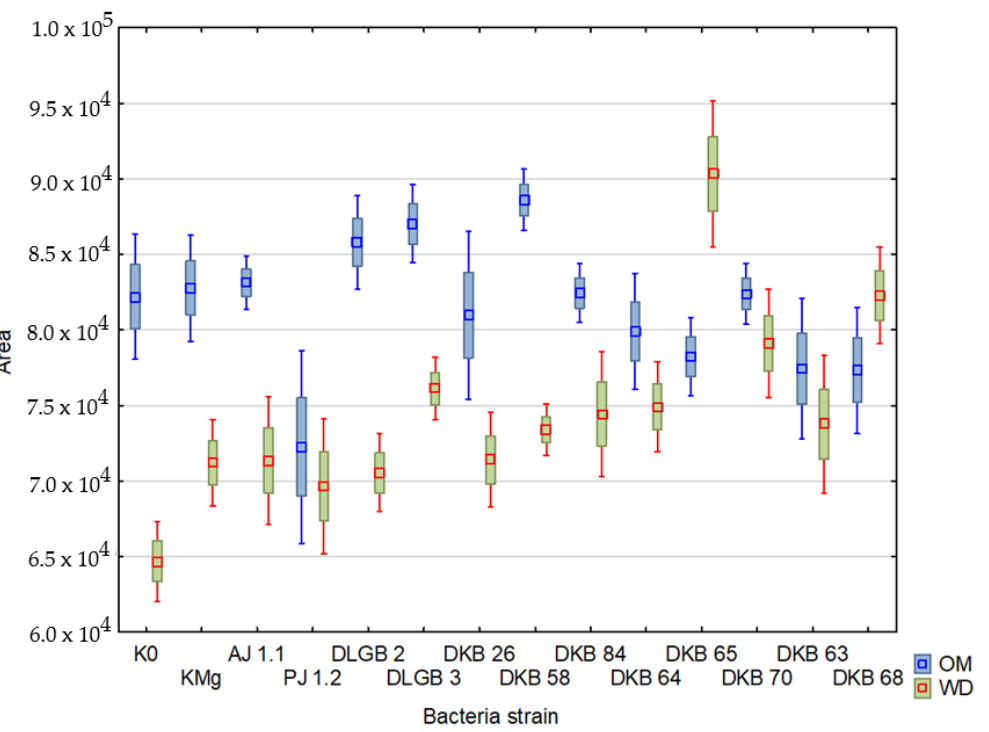
Figure 9. PI in the leaves of strawberry plants inoculated with rhizosphere bacteria growing under different substrate moisture levels, where: OM — optimal moisture, WD — water deficit.